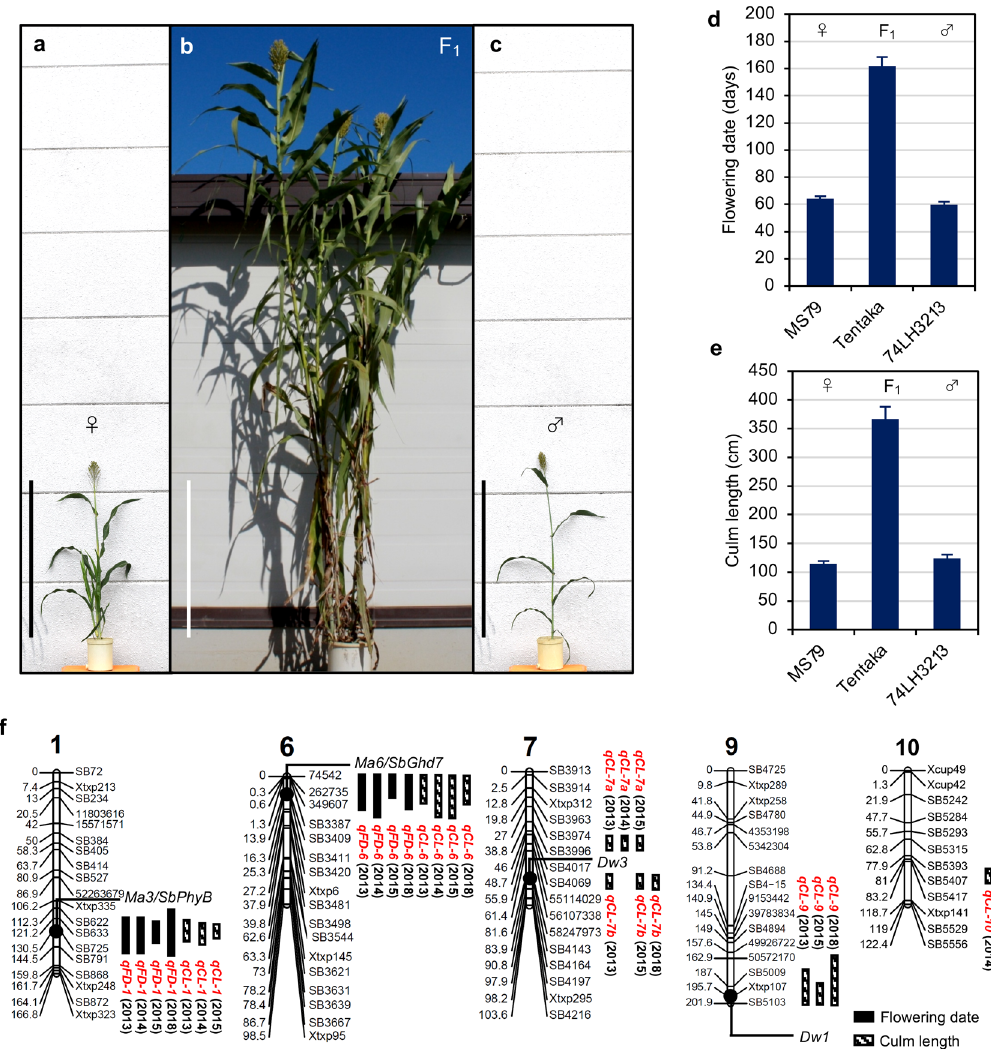
1 m. ( d ) Flowering date (FD) and ( e ) Culm length (CL) after flowering were investigated in the plants from the parental lines and the F 1 generation (n ≥ 6, means ± SD). ( f ) An F 2 population from a cross between MS79 and 74LH3213 was analysed for FD and CL. QTLs for FD and CL with P values < 0.05 are presented on the graphical map of the chromosomes, above which the chromosome numbers were mentioned. The positions and names of the DNA markers used for the analysis are indicated on the left and right sides, respectively. The QTL name is indicated in